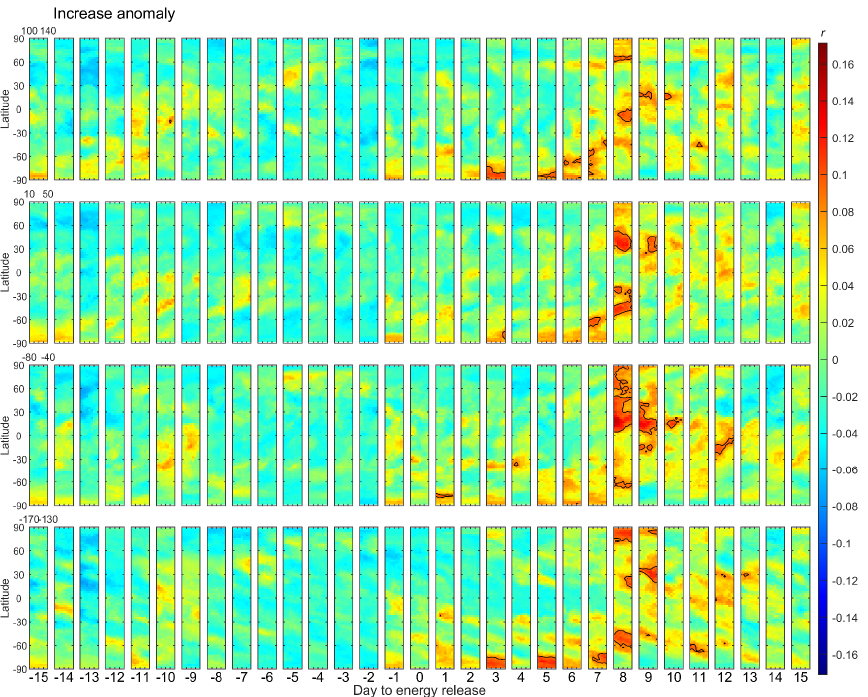
Figure 3. Same as Figure 2 for the results of occurrence times of TEC increase anomalies.